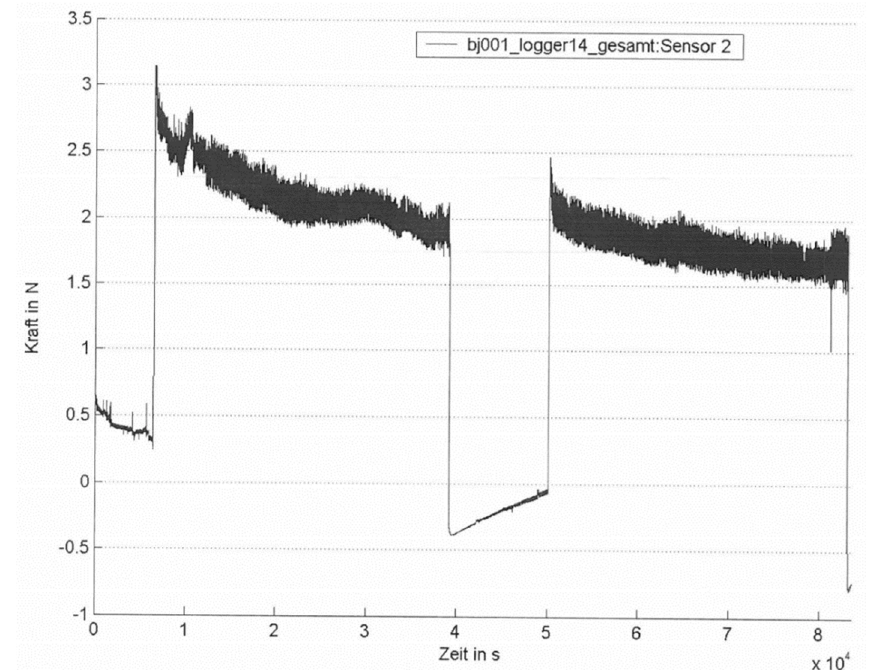
Figure 5. Example of an individual suture tension diagram (intervention group). Two 9 h intervals with 30 mm Hg IAH. Total recording time: 23.3 h (8.4 × 10 4 s). ( x -axis label: time in s; y -axis label: force in N).